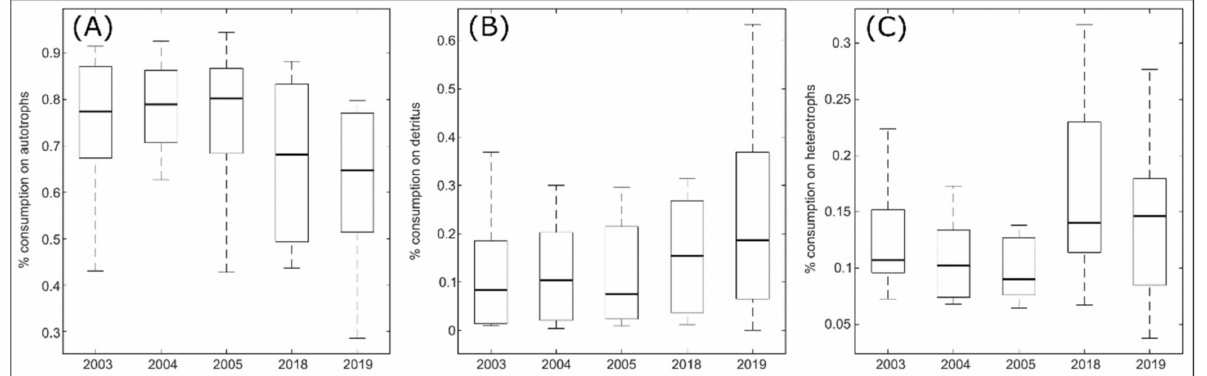
Figure 7. Percentage of total consumption on autotrophs ( A ), detritus ( B ) and heterotrophs ( C